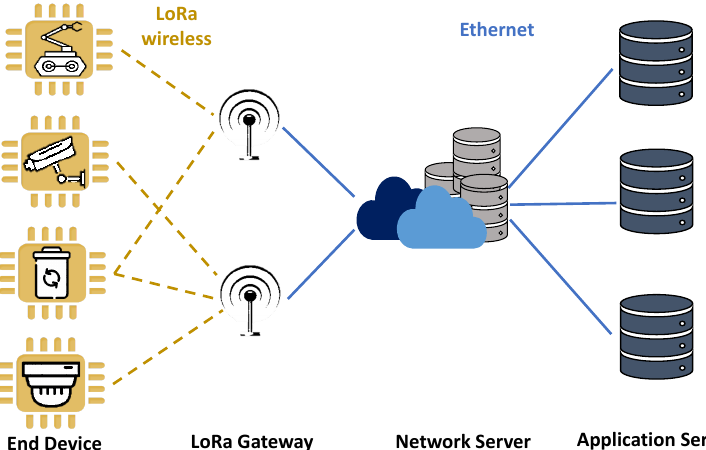
Figure 3. The LoRaWAN